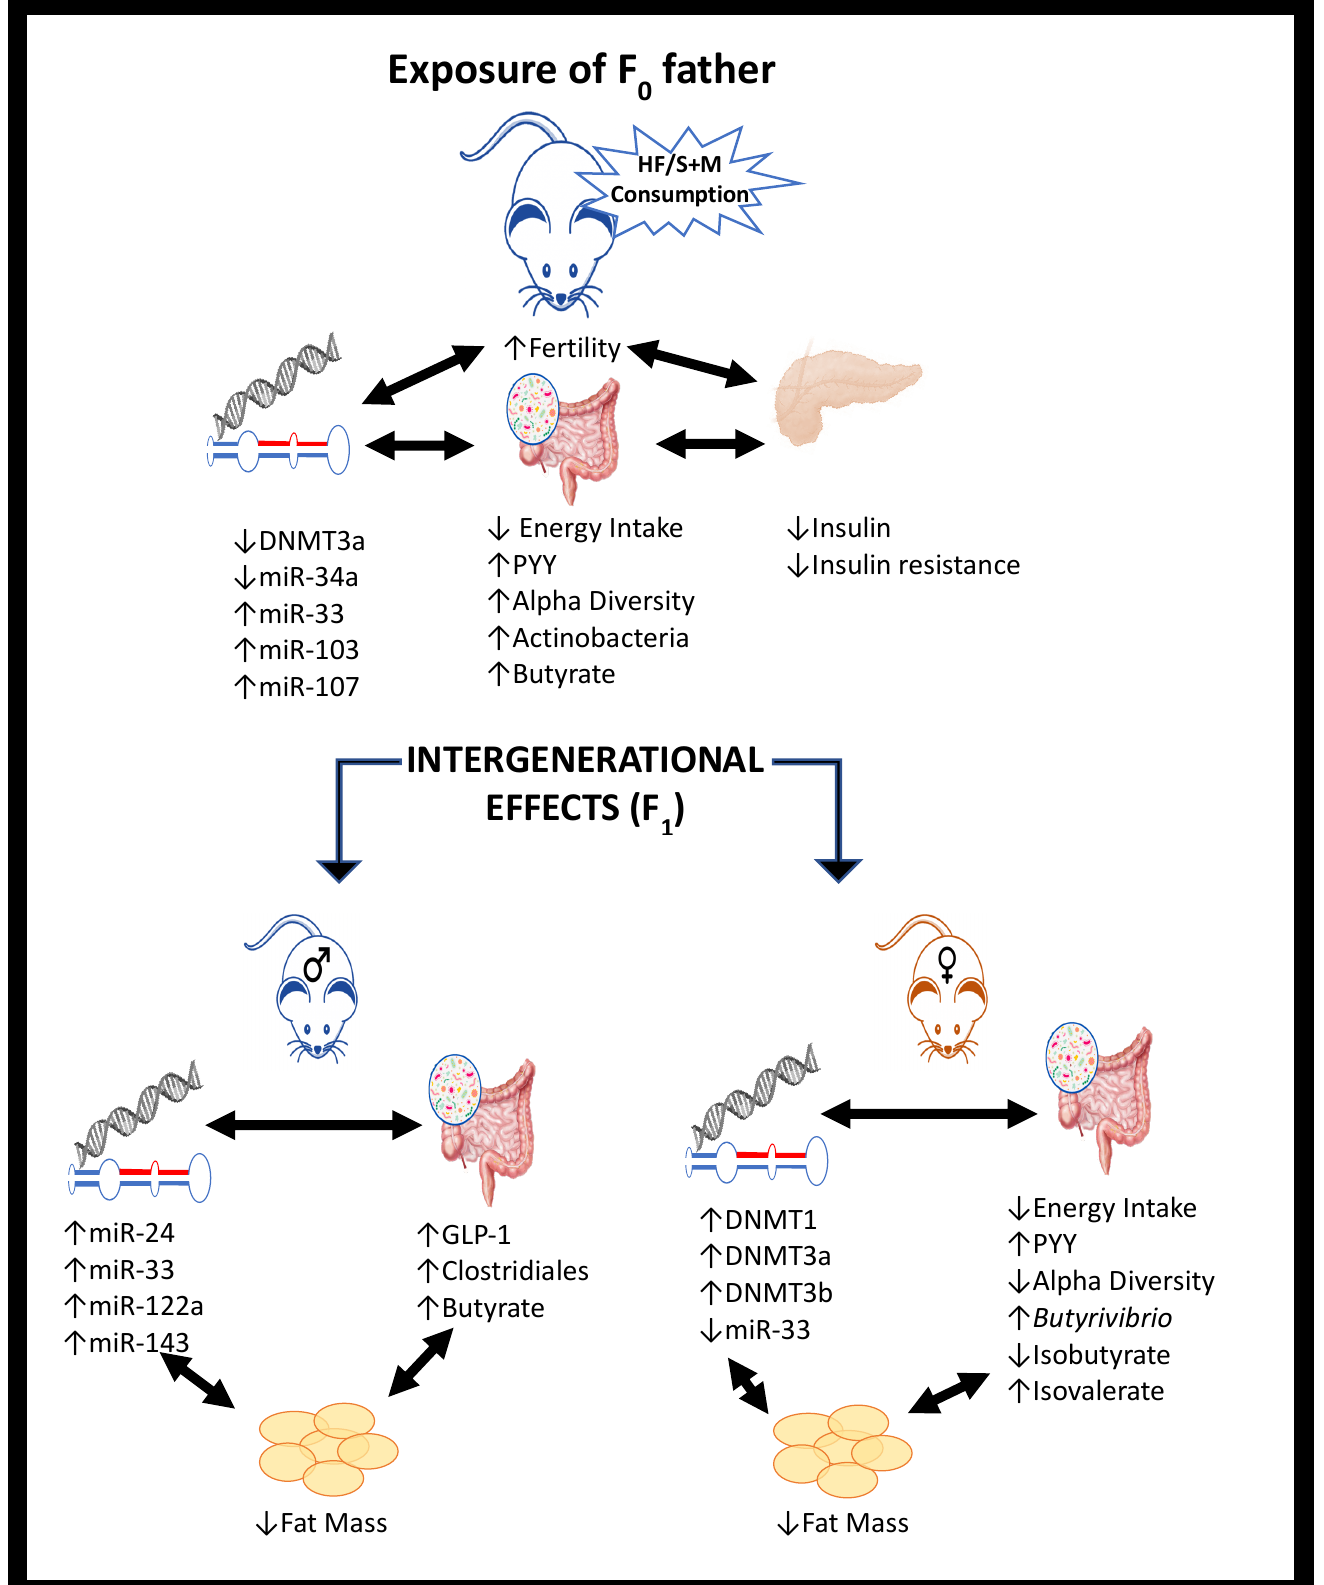
Figure 5. An overall summary of the major findings in fathers and adult offspring following a HFS diet, supplemented with a methyl donor cocktail of betaine, choline, folic acid and vitamin B12. All data are compared to a control HF/S